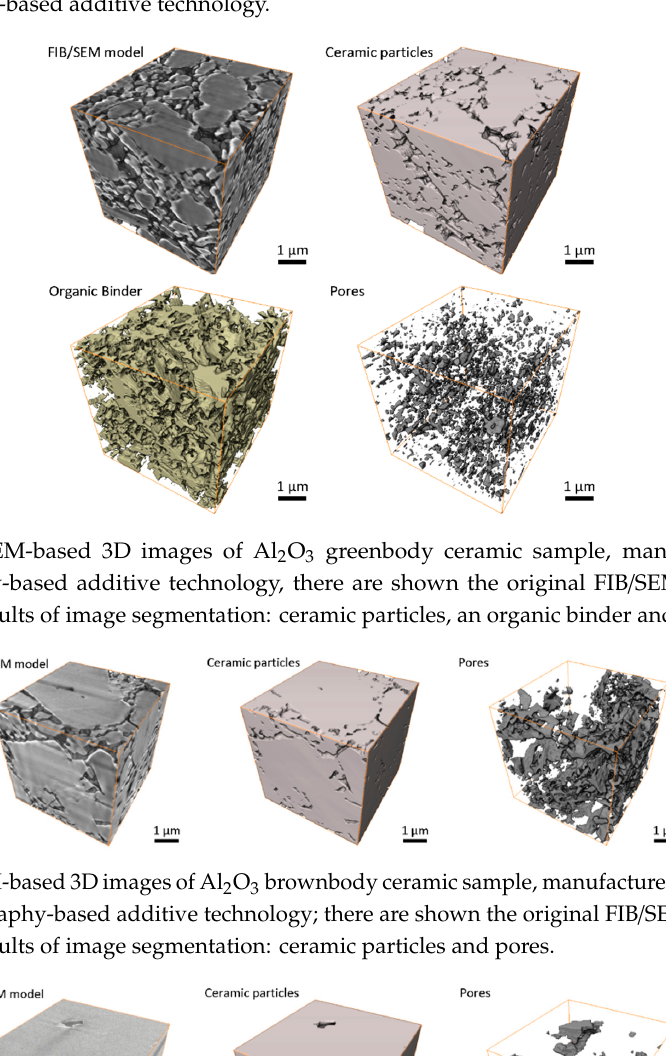
Figure 6. Typical slices acquired with Focused Ion-Beam SEM (FIB/SEM) characterization procedure for Al ₂ O ₃ greenbody, brownbody and sintered ceramic samples, manufactured and processed with stereolithography-based additive technology.